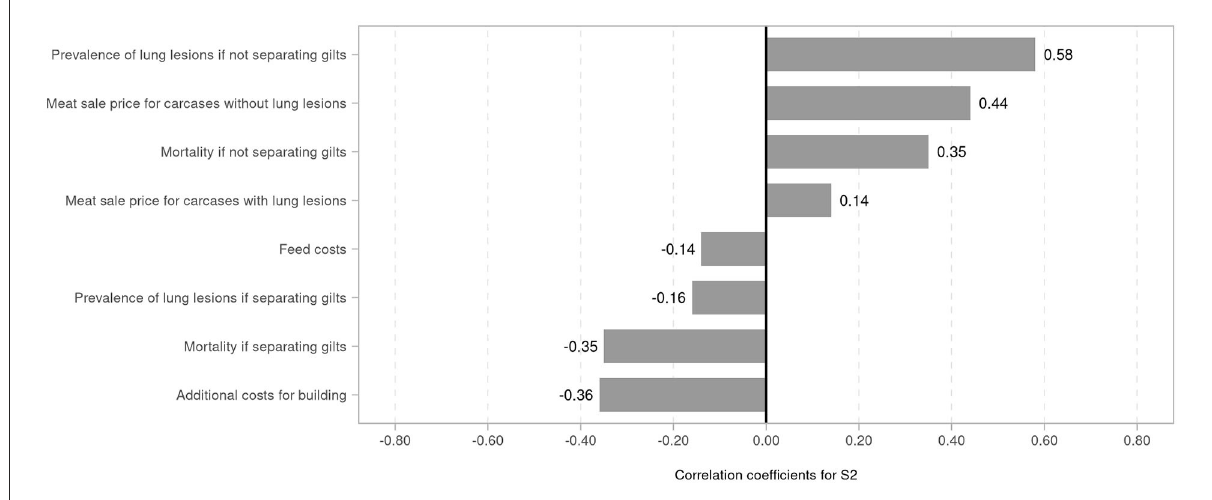
FIGURE2 Tornado plot with correlation coefficients of drivers of net benefit change when keeping purchased gilts separated (strategy